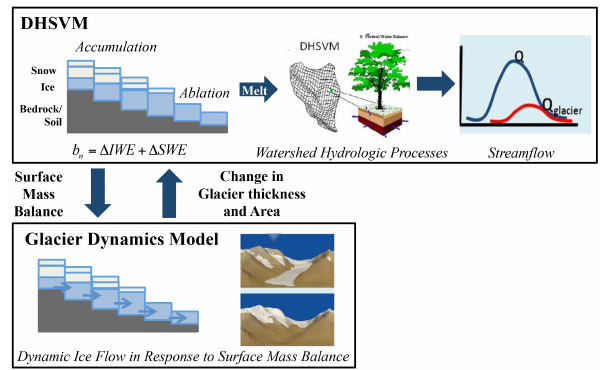
Fig. 1. Schematic of major processes and integration of the Glacier Dynamics Model (GDM) and DHSVM. Accumulation and ablation of snow/ice is simulated in DHSVM. The surface mass balance is calculated and supplied to the GDM at a monthly time-step. Dy- namic ice flow is simulated in GDM based on surface elevation changes. After each monthly glacier dynamics calculation the ice layer in the DHSVM model is updated based on simulated ice